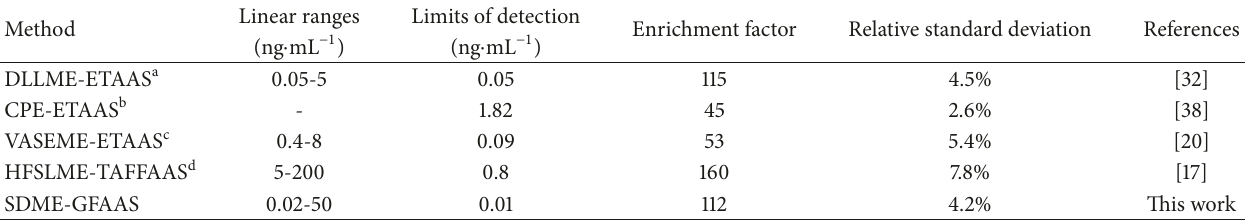
Table 3: Comparison of the proposed method with other methods for determination of antimony (III).